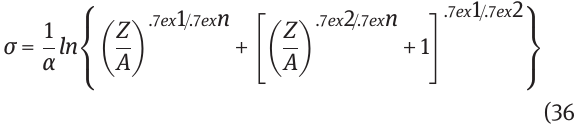
Figure 18: Relationship between ln sinh ασ ð Þ½ (cid:2) and 1000 T